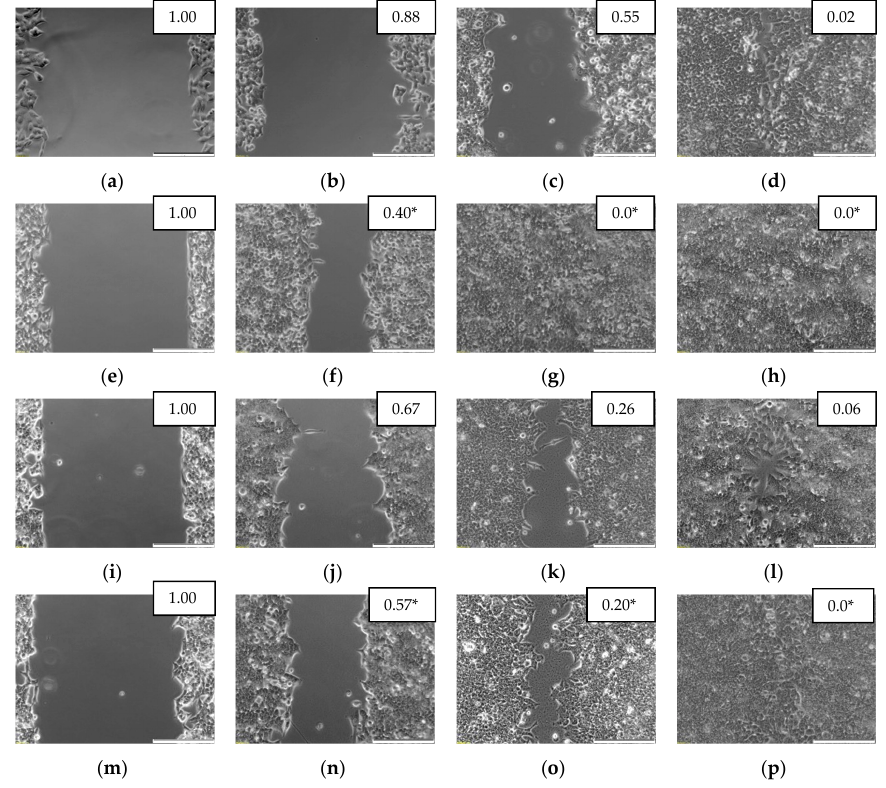
Figure 17. Impact of stimulation with 100 ng/mL of IL-4 or IL-13 on HCT 116 cells—a scratch assay (representative data): ( a ) control for IL-4 at 0 h; ( b ) control for IL-4 at 24 h; ( c ) control for IL-4 at 48 h; ( d ) control for IL-4 at 72 h; ( e ) stimulated with IL-4 at 0 h; ( f ) stimulated with IL-4 at 24 h; ( g ) stimulated with IL-4 at 48 h; ( h ) stimulated with IL-4 at 72 h; ( i ) control for IL-13 at 0h; ( j ) control for IL-13 at 24 h; ( k ) control for IL-13 at 48 h; ( l ) control for IL-13 at 72 h; ( m ) stimulated with IL-13 for 0 h; ( n ) stimulated with IL-13 at 24 h; ( o ) stimulated with IL-13 at 48 h; ( p ) stimulated with IL-13 at 72 h. Scale bars (200 µ m) are indicated in lower right corner of each photograph. Numeric data in the upper right corner of each photograph indicate a ratio of gap (scratch) area at given time point to gap area at time 0. The ratios in interleukin-stimulated cells significantly ( p < 0.01) di ff erent from their unstimulated counterparts are marked with asterisks